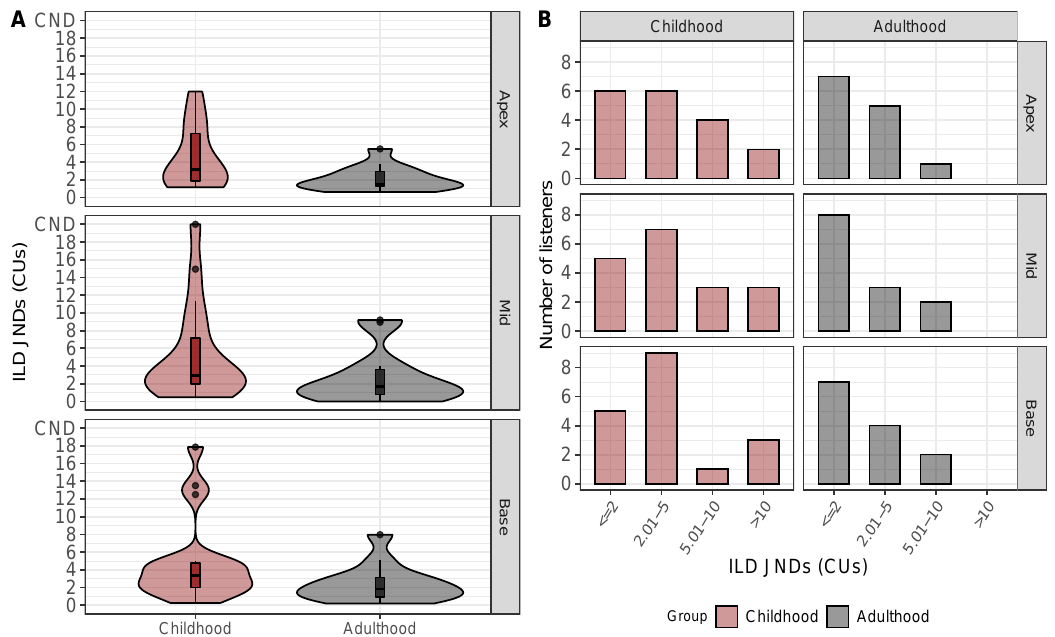
Figure 5. Shows the distribution of ( A ) ILD Just-noticeable di ff erences (JNDs) as a box plot and violin plot for all listeners as a function of age at onset of deafness group. A wider distribution (i.e., greater thickness) on a violin plot corresponds to a greater number of listeners with a given JND on the y-axis. Black dashed line indicates “could not determine” (CND) threshold for ILD JNDs; ( B ) shows histograms of ILD JNDs, for each age group, binned according to levels of performance ranging from “good” ( < 2 CUs) to “poor” ( > 10 CUs).